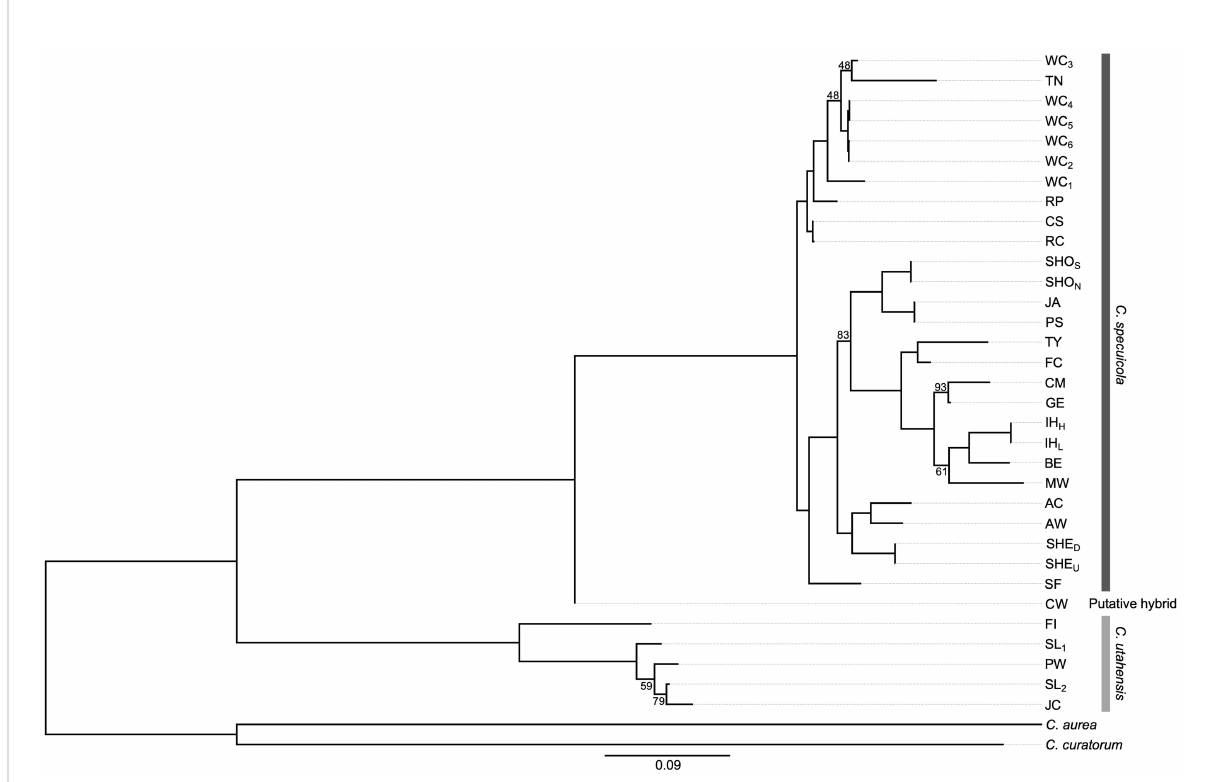
FIGURE 2 Maximum likelihood phylogeny for Carex samples inferred with PhyML (Guindon et al., 2010) using smart model selection (Lefort et al., 2017). Tip labels indicate sampling sites and are de fi ned in Table 1. All nodes were highly supported (>95% bootstrap values) except where